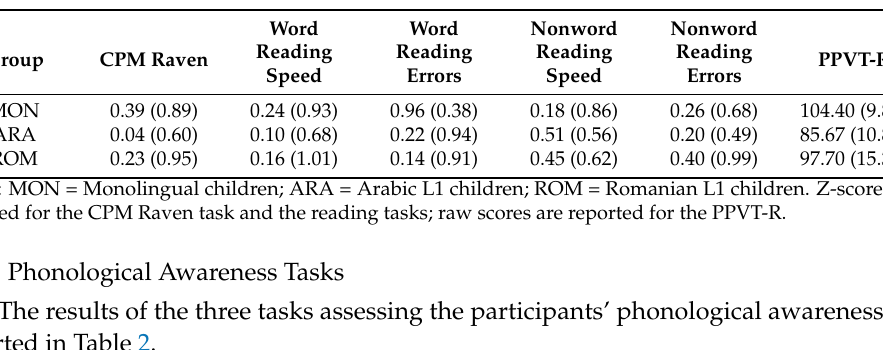
Word Word Nonword Reading Reading Reading Speed Errors